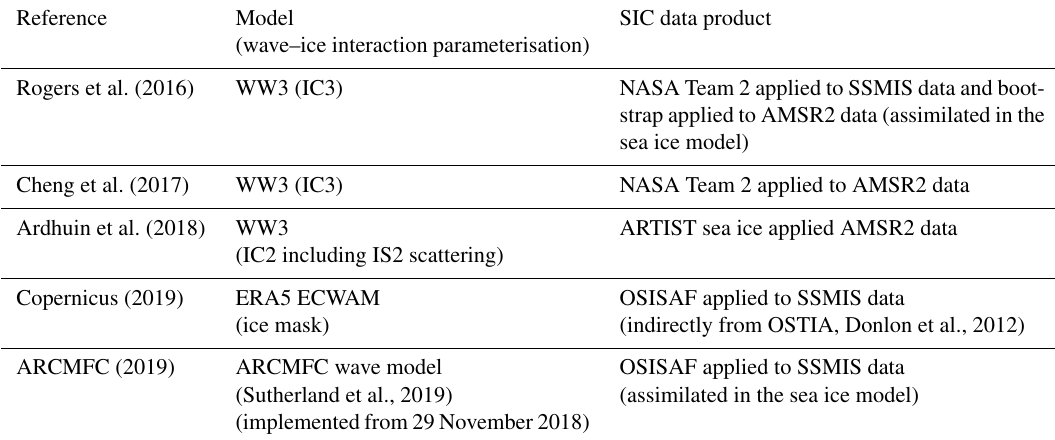
Figure 9. TodaiWW3-ArCS simulation showing H m and SIC transects on 21 November 2018, 21:00, for the northeasterly off-ice wave case 0 as shown in Fig. 6b. (a) H m uncertainty map with 0.01 (dotted), 0.50 (dashed), and 0.85 (dash-dotted) mean( c i ) contours shown in black. 0 (b, d) Model H m (b) and SIC c i (d) forcings along the green line are shown for the (cid:49)c i hindcast experiment. (c, e) Model H m 0 c i (e) for an off-ice wave transect along the magenta line are shown for the (cid:49)c i hindcast experiment. The figure schematics of SIC forcing follow Fig. 2. Magenta markers indicate the wind forcing magnitude, and dotted black lines represent (cid:49)H m Table 2. A list of SIC data products used for various wave–ice interaction modelling